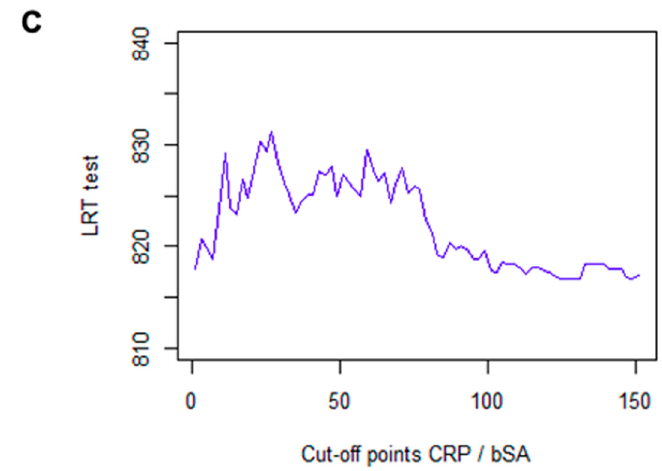
Figure 2. Analysis of the CRP/SA cutoff value for prediction in the multivariate model of the main outcome. ( A ) OR and 95%CI associated with the different cutoff values of CRP/bSA. ( B ) Area under the ROC curve for different cut-off values of CRP/bSA. ( C ) Analysis of goodness of fit of different cutoff values by means of the likelihood ratio test. Abbreviations: bSA, baseline serum albumin (g/dL) at admission; CRP, C-reactive protein (mg/L); LRT, likelihood ratio test.